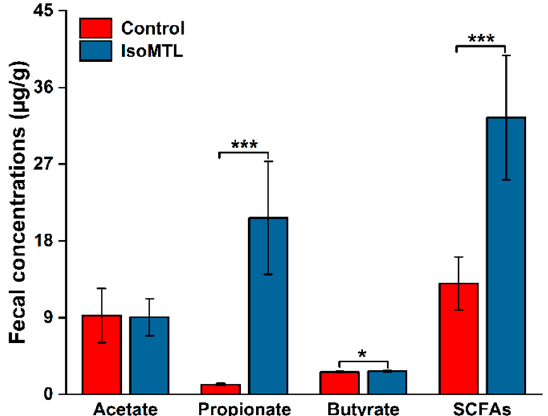
Figure 9. Dietary isomaltulose affects the production of SCFAs in fecal samples. The concentration of total short ‐ chain fatty acids (SCFAs) refers to the sum of acetate, propionate, and butyrate. * represents the differences between control and IsoMTL rats (* p < 0.05, *** p < 0.001).